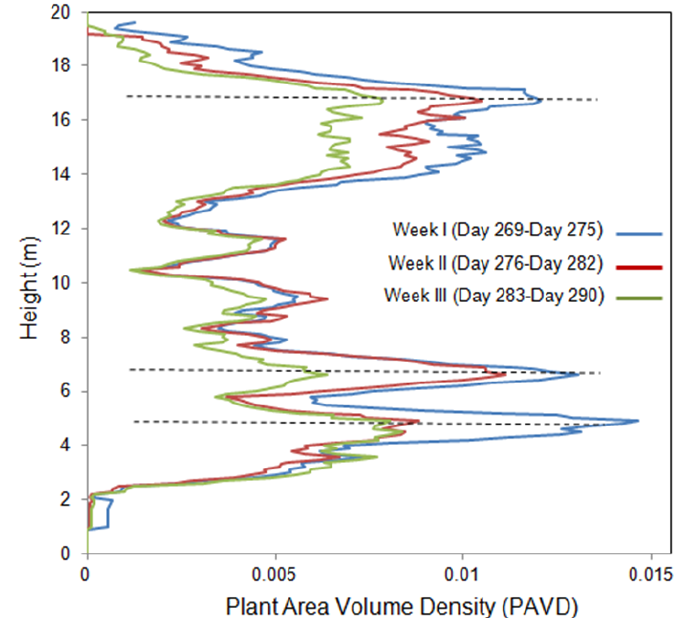
Figure 4. Time-series of Plant Area Volume Density (PAVD) values calculated by the VEGNET IML during September 26 and October 17, 2013; the volume density distribution is plotted against height in order to show the vertical distribution of biomass in the forest; values have been averaged by week for visualization purposes; three height strata with high PAVD values represent biomass concentration on the understory (trunks, shrubs, and juvenile trees), subcanopy (branches and leaves of subcanopy trees and trunks of the canopy trees in the understory) and canopy trees (canopy branches and